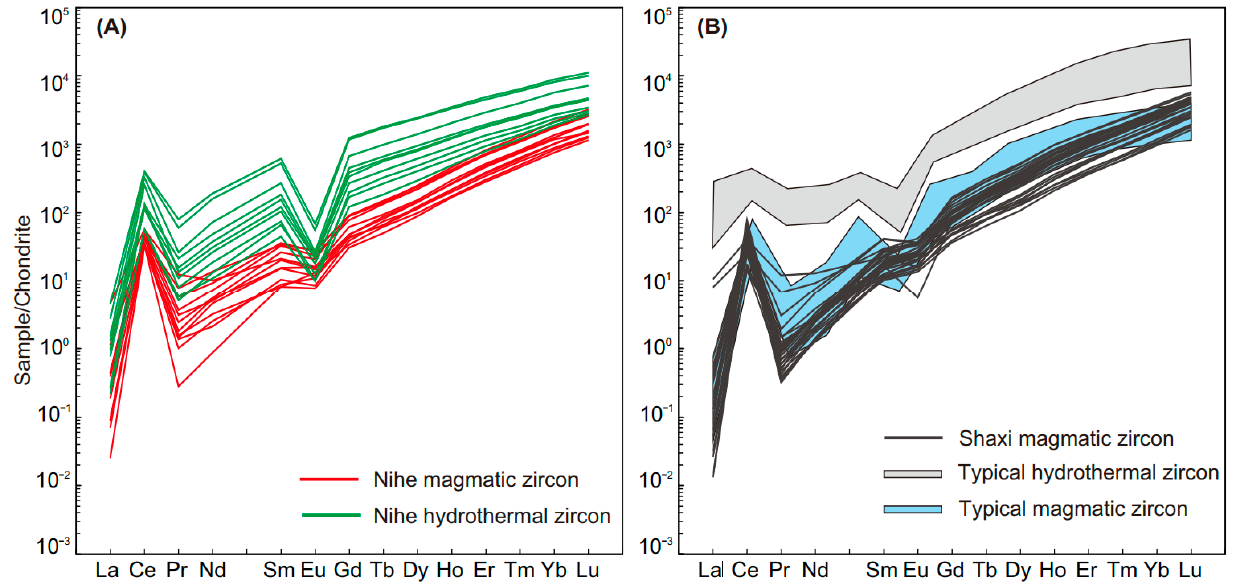
Figure 6. Chondrite-normalized REE patterns of zircons from the porphyry of Nihe ( A ) and Shaxi ( B ).